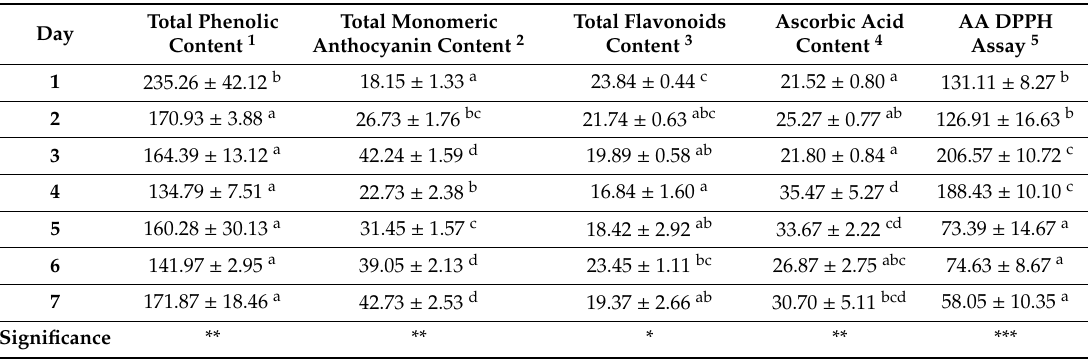
Table 3. Fruits stored at 1 ◦ C in fridge, packaged in Nanoactive B film. E ff ect of storage period, on the total phenolic content, total monomeric anthocyanin content, total flavonoid content, the ascorbic acid content, and the antioxidant activity DPPH parameters in red raspberries (cv. Erika). The results are the mean of three replicates ± Standard Deviation. *** ( P ≤ 0.001); ** ( P ≤ 0.01); * ( P ≤ 0.05). The letters represent the significant di ff erence vertically at P ≤ 0.05.